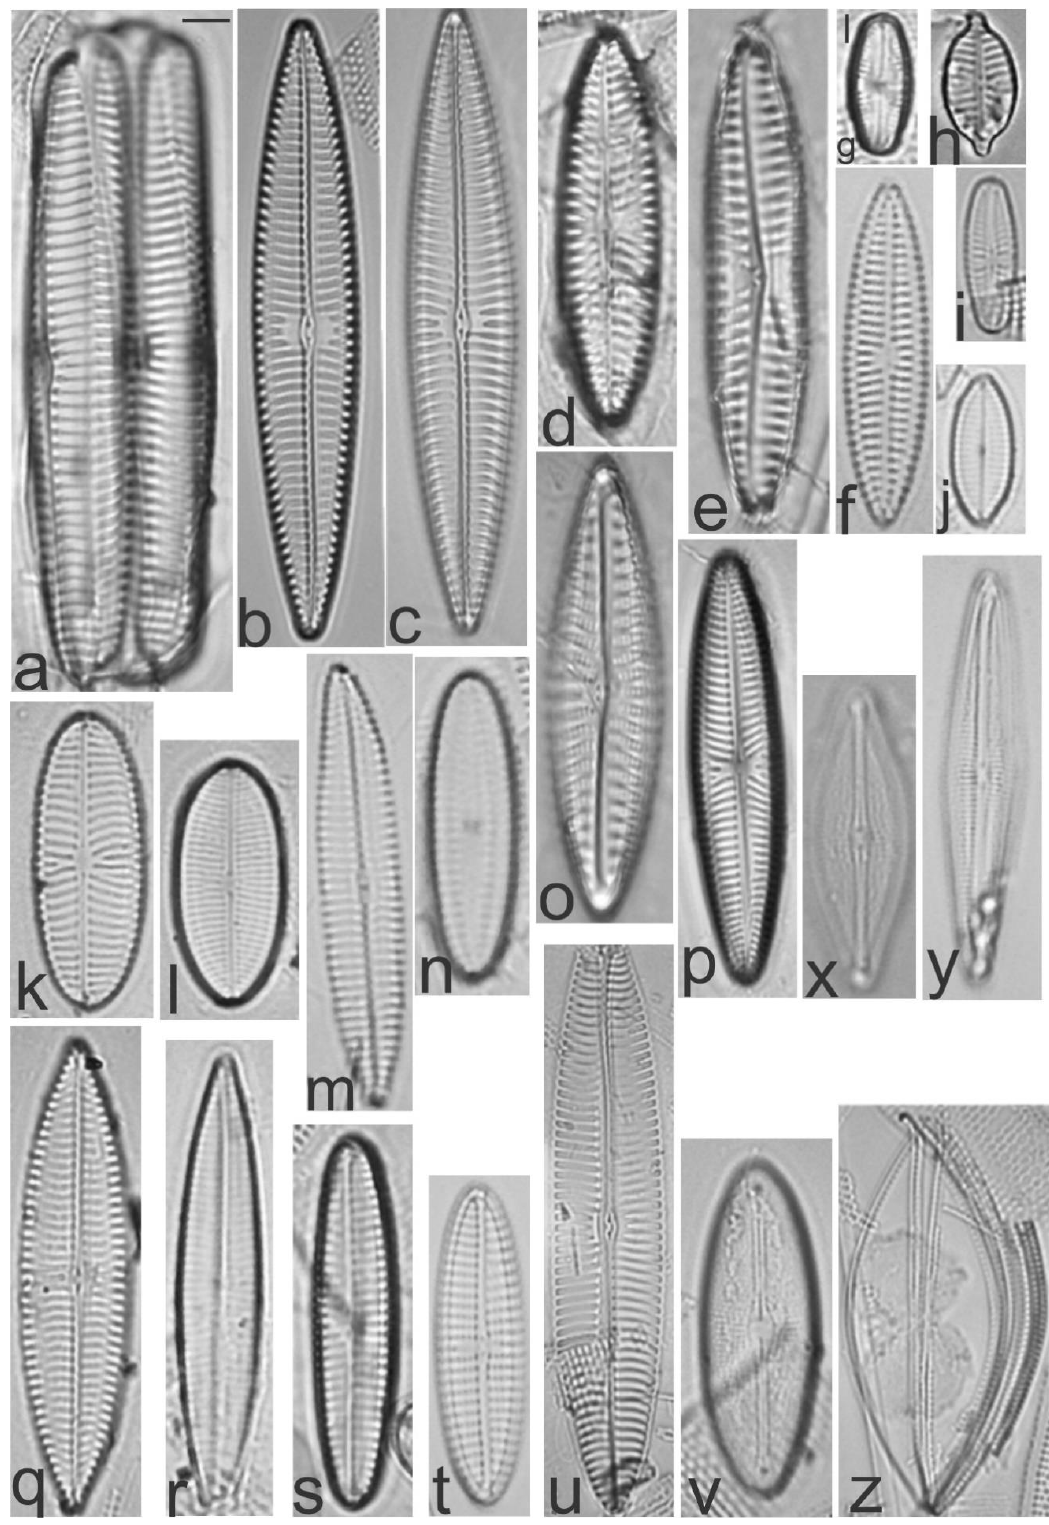
Figure 28. ( a – c ) Navicula longa ; ( d ) N. pennata ; ( e ) N. bipustulata ; ( f ) N. zostereti ; ( g ) Luticola mutica ; ( h ) Navicula platyventris ; ( i ) Dickieia sp.; ( j ) Navicula sp. 1; ( k ) N. digitoradiata ; ( l ) Navicula sp. 3; ( m ) Navicula subrostellata ; ( n ) Biremis ambigua ; ( o ) Navicula inflexa ; ( p ) N. digitoconvergens ; ( q ) N. johanrossii ; ( r ) Craticula halophila ; ( s ) Navicula sp. 2; ( t ) Navicula athenae ; ( u ) N. arenaria var. rostellata ; ( v ) Parlibellus cf. phoebeae ; ( x ) P. cf. delognei ; ( y ) P. cruciculoides ; ( z ) Halamphora pseudohyalina . Scale bar = 5 μm.